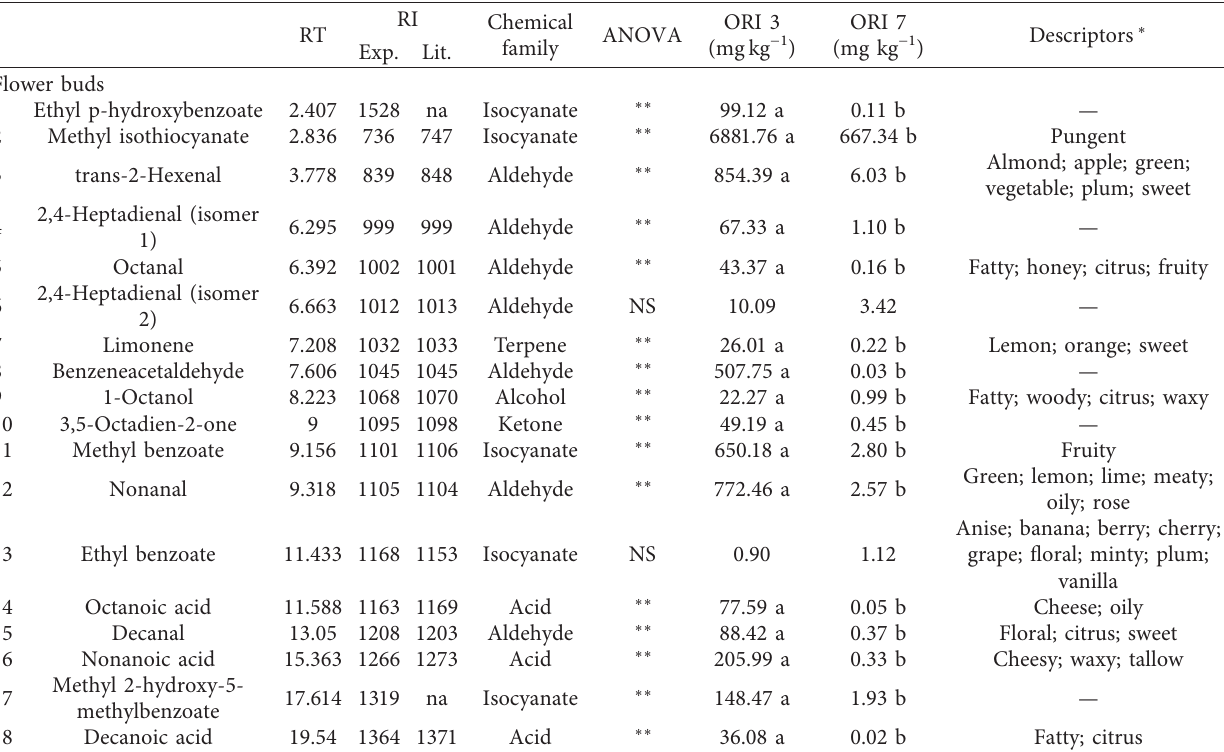
Table 4: Volatile compounds of Capparis spinosa L. in flower buds detected using headspace solid phase microextraction (HS-SPME) with GC-MS.